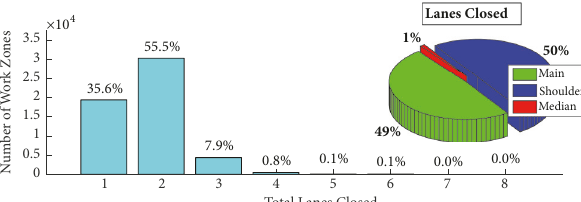
Figure 2: Most WZs would have one or two lanes closed, while closures of more than four lanes were very rare and typically occurred close to toll plazas. For the most part, closures affected main and shoulder